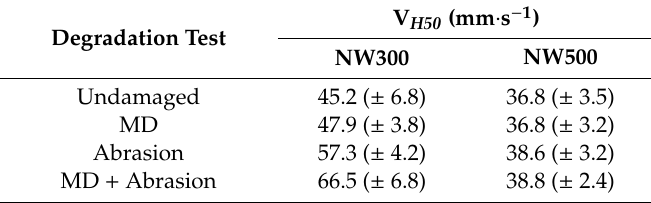
Table 5. V H50 of the nonwoven geotextiles NW300 and NW500.